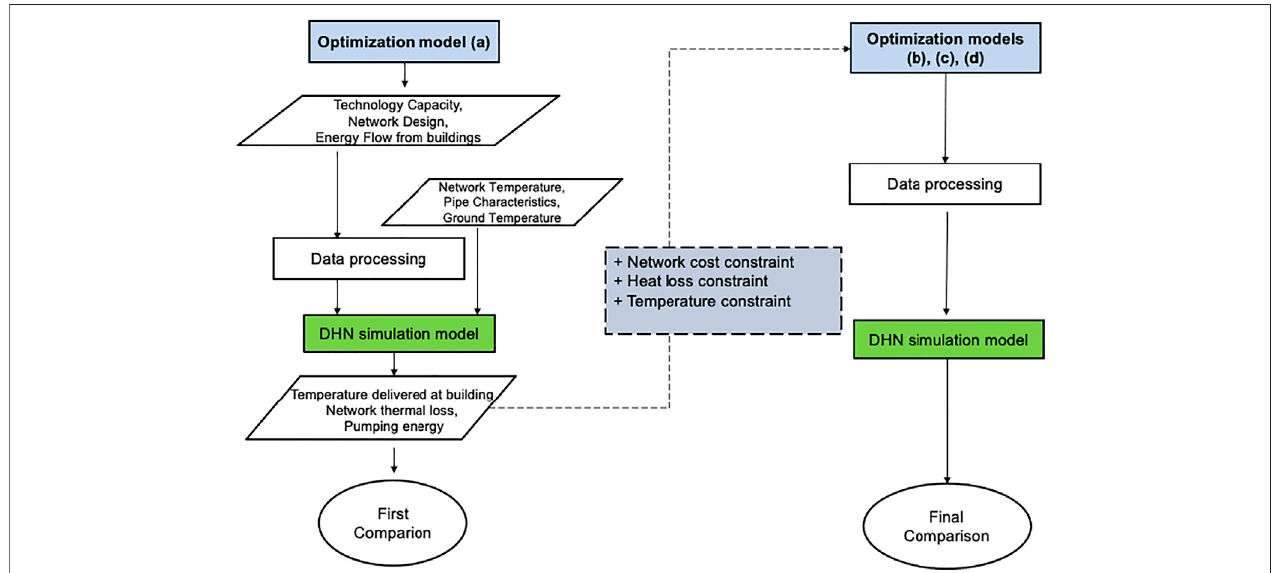
FIGURE 1 | General overview of the